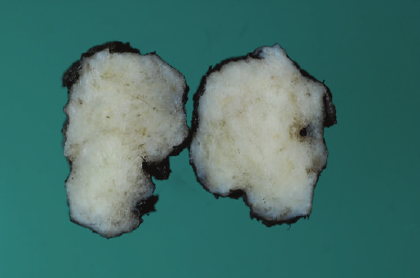
Figure 2: Excised breast mass cut to reveal the homogenous white fibrous parenchyma.